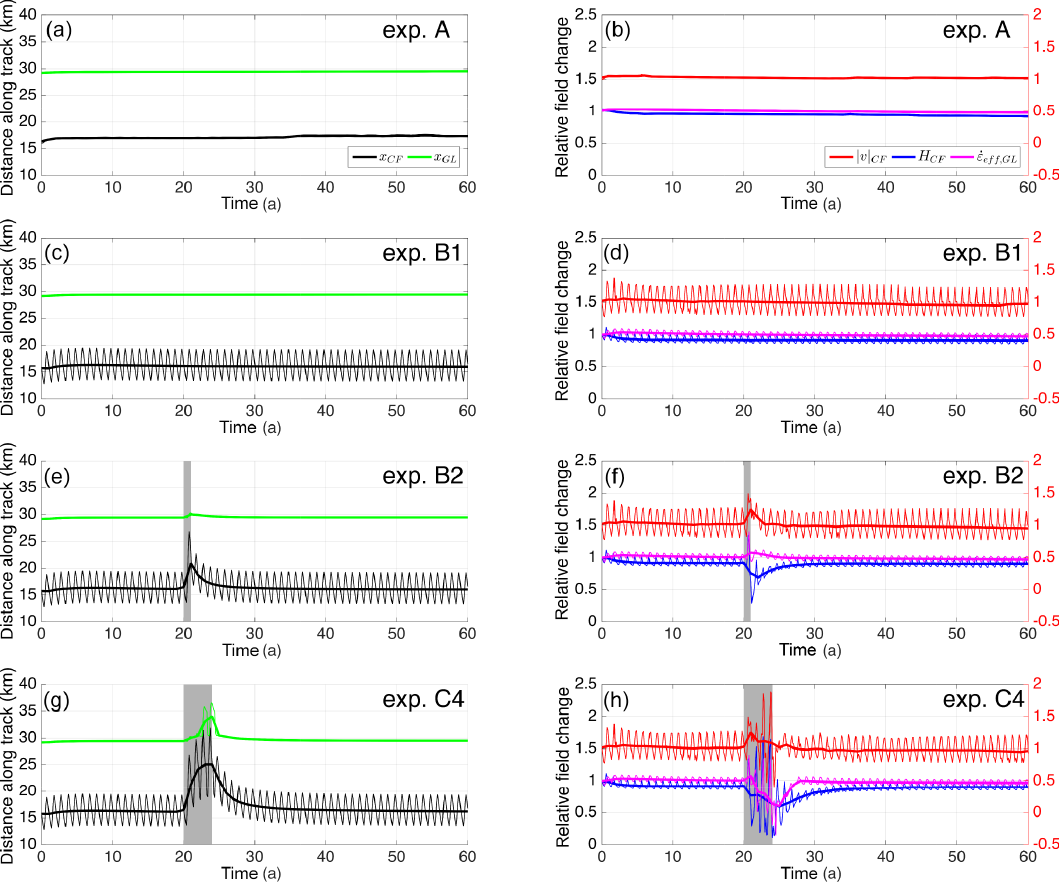
Figure 7. Calving front and grounding line positions along-trough (left column), calving front thickness, ice velocity, and effective strain rate relative to their initial value along-trough (right column) over time for experiments A, B1, B2, and C4. Perturbation intervals are marked in grey. Relative values for ice velocity have been shifted up by 0.5 for better visibility (red y